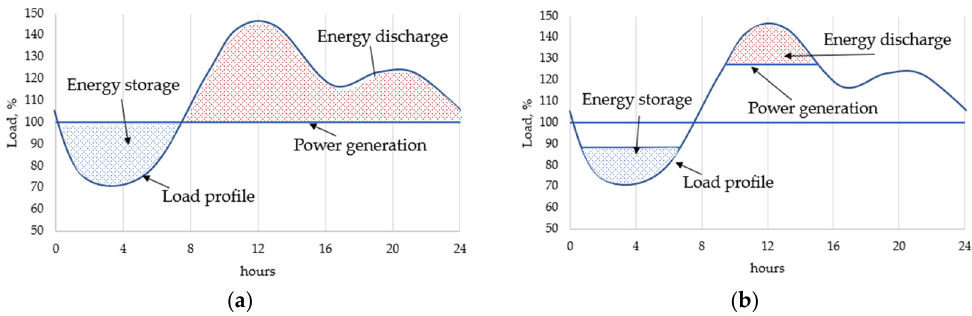
Figure 1. Accumulation system operation in a power grid : (a ) load leveling; ( b ) peak shaving.